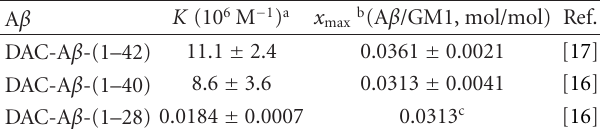
a Binding constant.